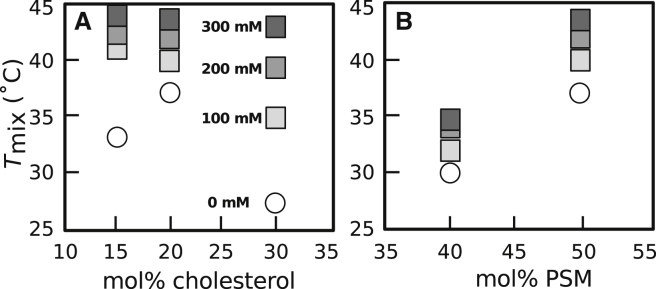
Miscibility transition temperatures for GUVs composed of POPC/PSM/cholesterol increase with the concentration of butanol in solution. (A) The molar ratio of POPC to PSM is held constant at 1:1 while the fraction of cholesterol is increased. (B) The fraction of cholesterol is held constant at 30 mol% while the ratio of PSM to POPC is increased. Each point represents a single experiment for which uncertainties are smaller than symbols.